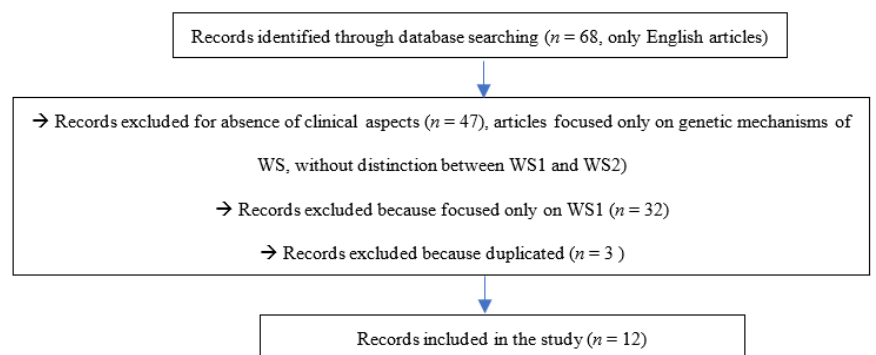
Figure 2. Article process selection.